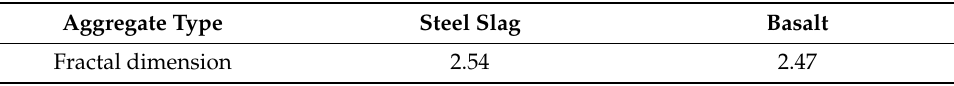
Table 3. Fractal Dimensions of the aggregate Surface Texture.